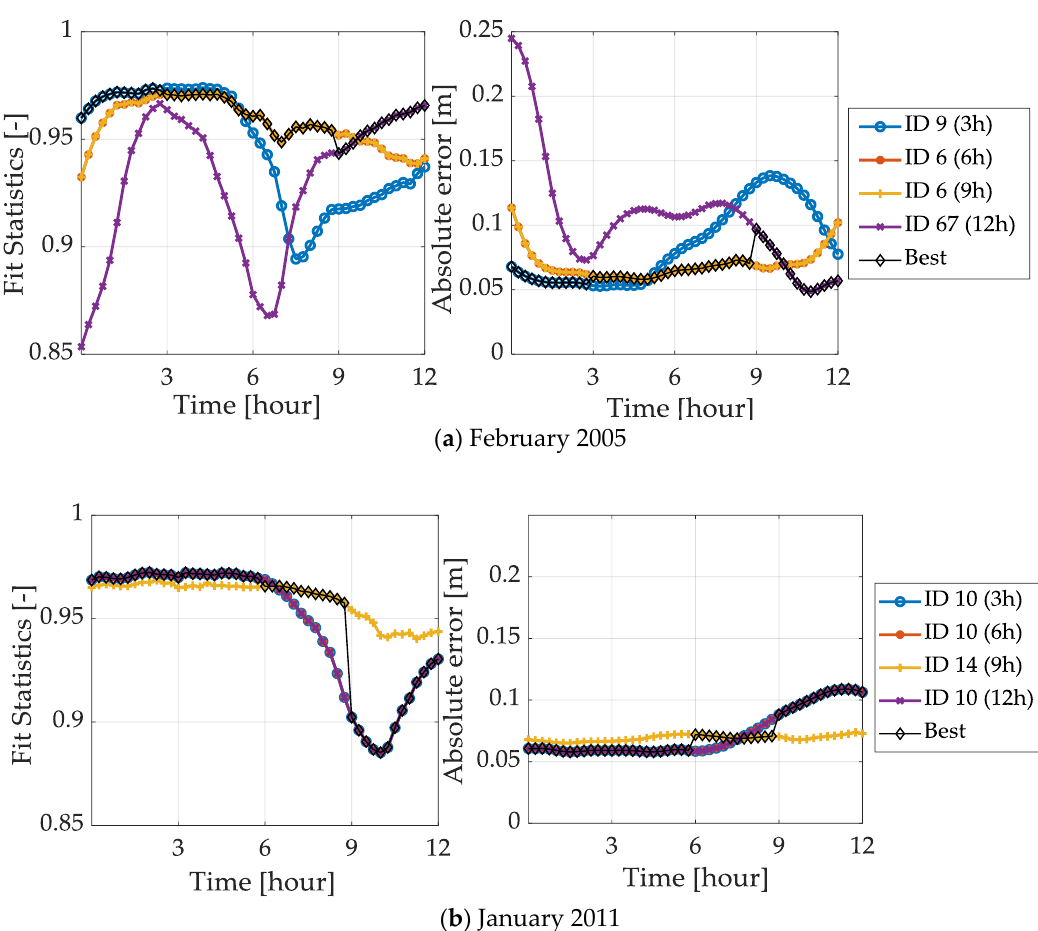
Figure 14. Update of the map selection for the advective events: ( a ) February 2005 and ( b ) January 2011.